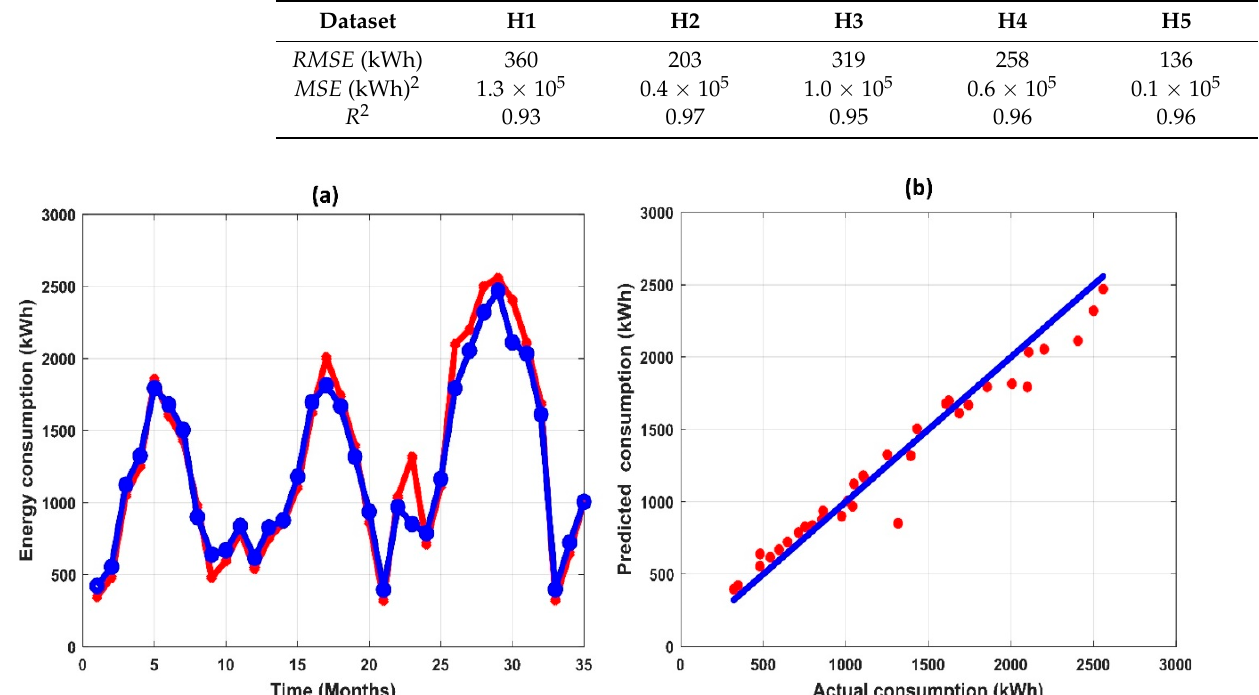
Table 3. Evaluation metrics of the training ML models for different datasets. The training model used is the fine Gaussian SVM algorithm.